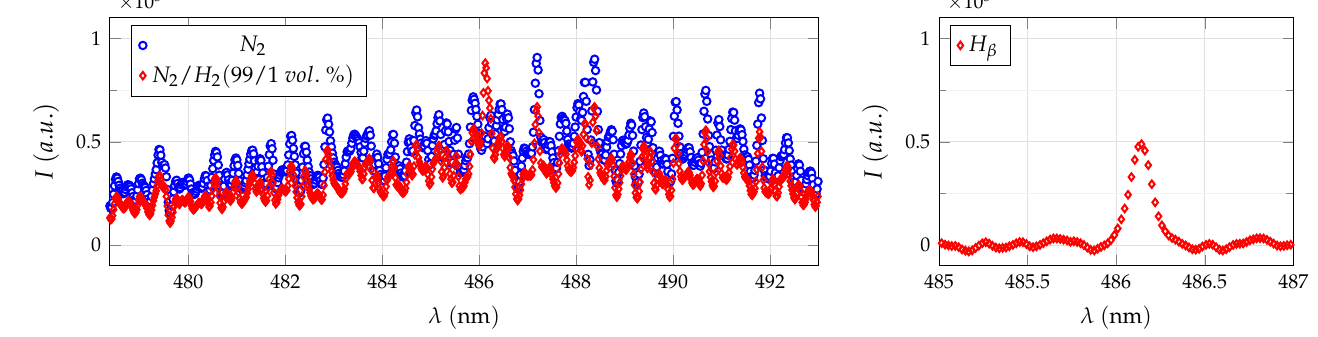
Figure 5. The left plot shows an N 2 and an N 2 / H 2 spectrum after correction with the radiance calibration standard, recorded with similar camera settings at nozzle axis ( r = 0 mm) for an axial distance of d = 2 mm. The plasma generator was operated at 60 kHz and the experimental setup was triggered at peak current of 1.0 A (power setting of 100%). The hydrogen β -line shown in the right plot is obtained after subtracting the pure nitrogen spectrum (multiplied by a variable scaling factor) from the hydrogen-containing measurement.